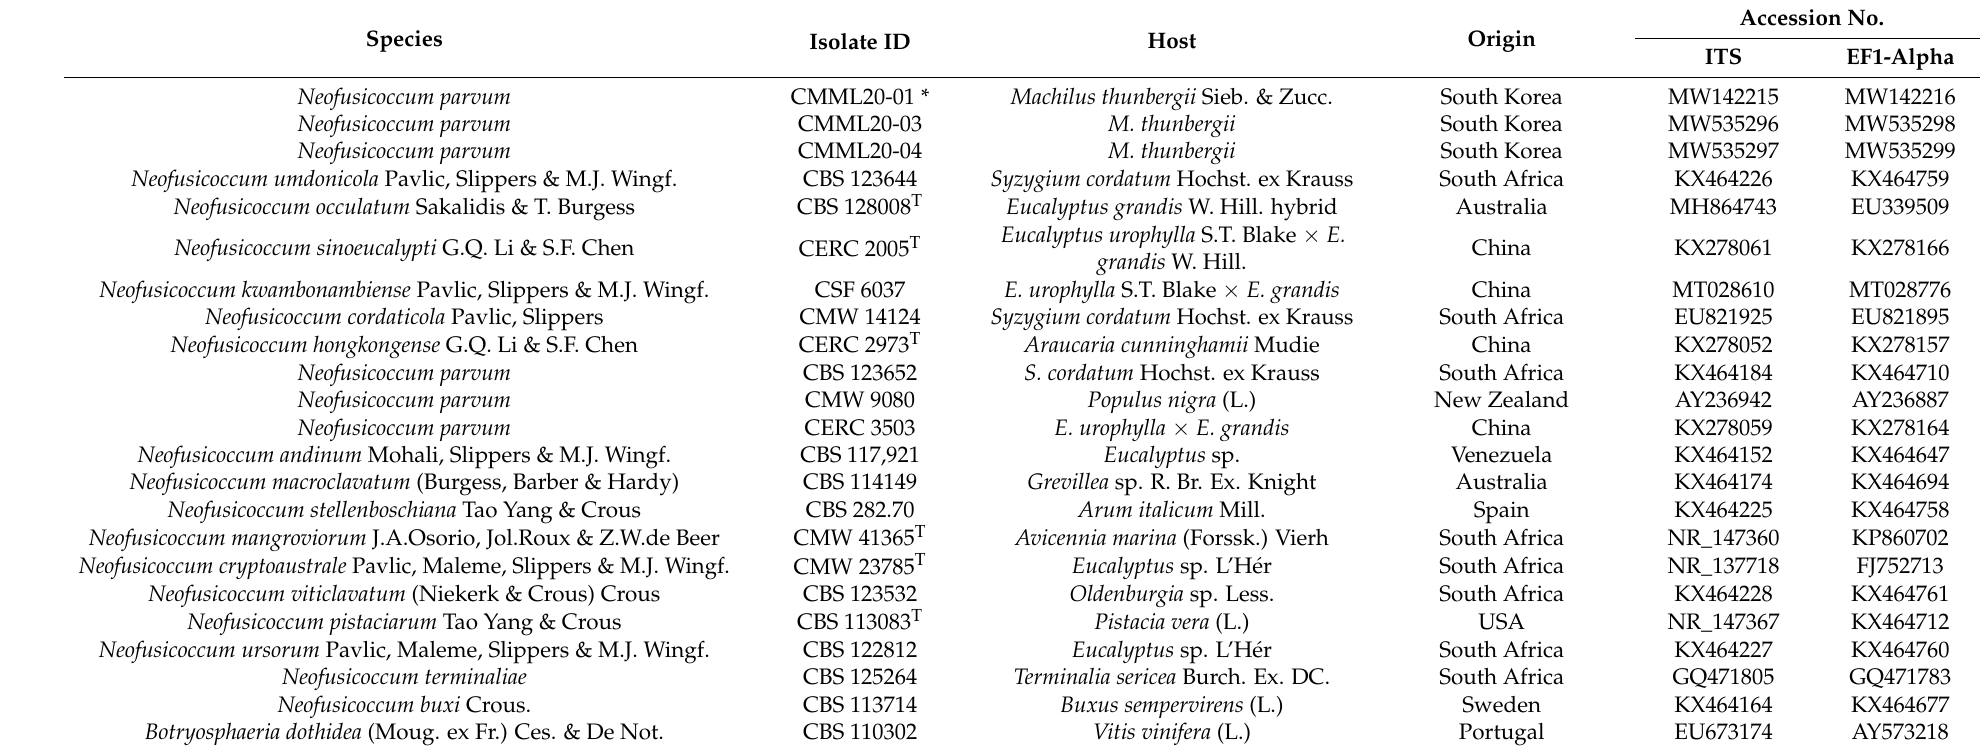
Table 1. Neofusicoccum species with their GenBank accession numbers used for phylogenetic